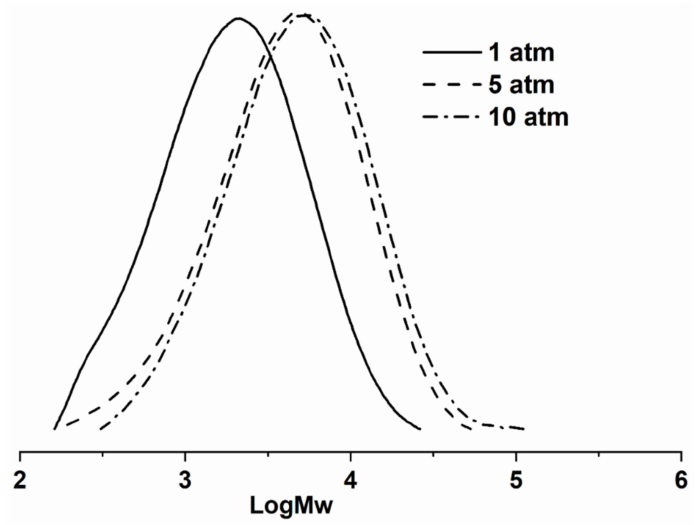
Figure 6. GPC curves showing log M w of the polyethylenes produced using Co1/ MAO as a function of the ethylene pressure (runs 5, 17, and 18, Table 2).